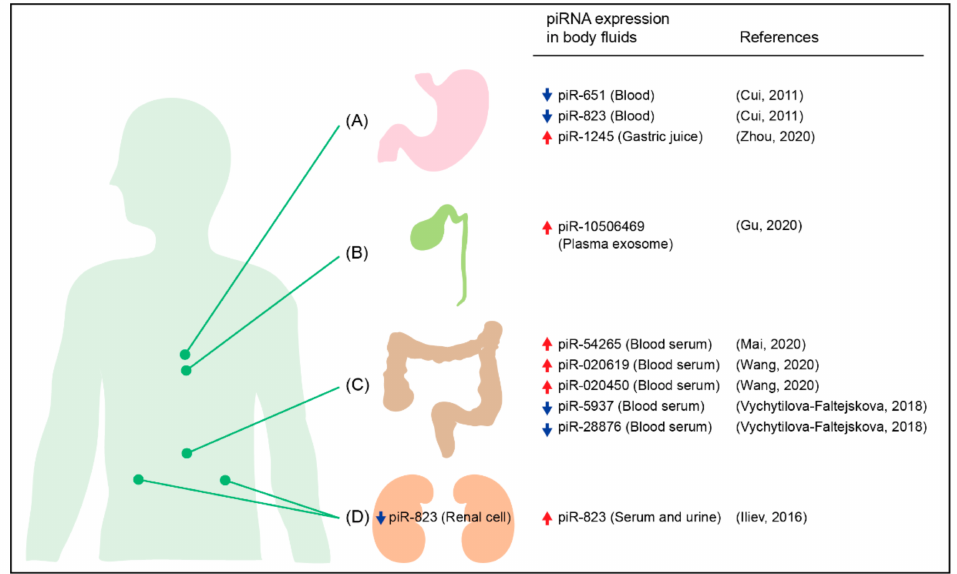
Figure 5. piRNAs as potential non-invasive biomarkers in cancer. ( A ) Gastric cancer. ( B ) Biliary tract cancer. ( C ) Colorectal cancer. ( D ) Renal